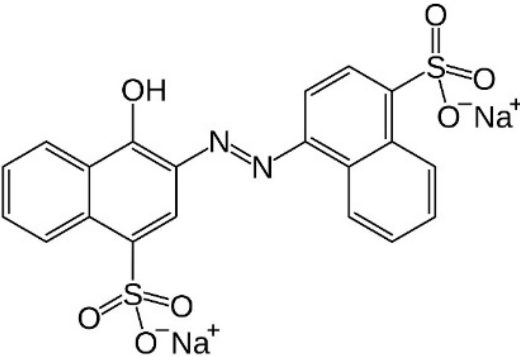
Figure 13. Formula of carmosine.